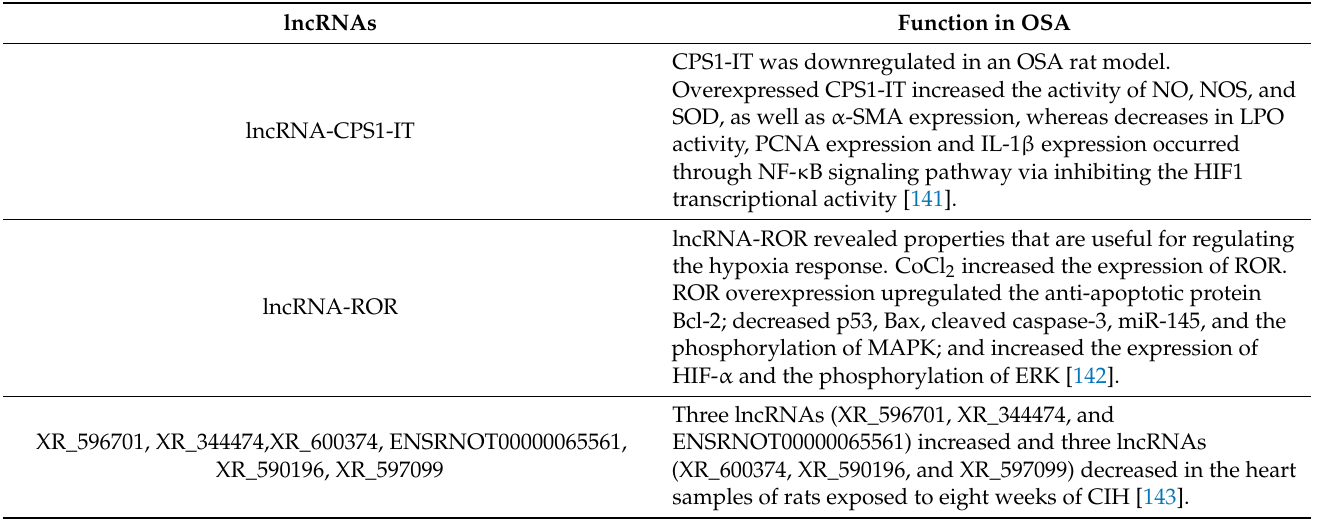
Table 3. The lncRNAs involved in OSA.